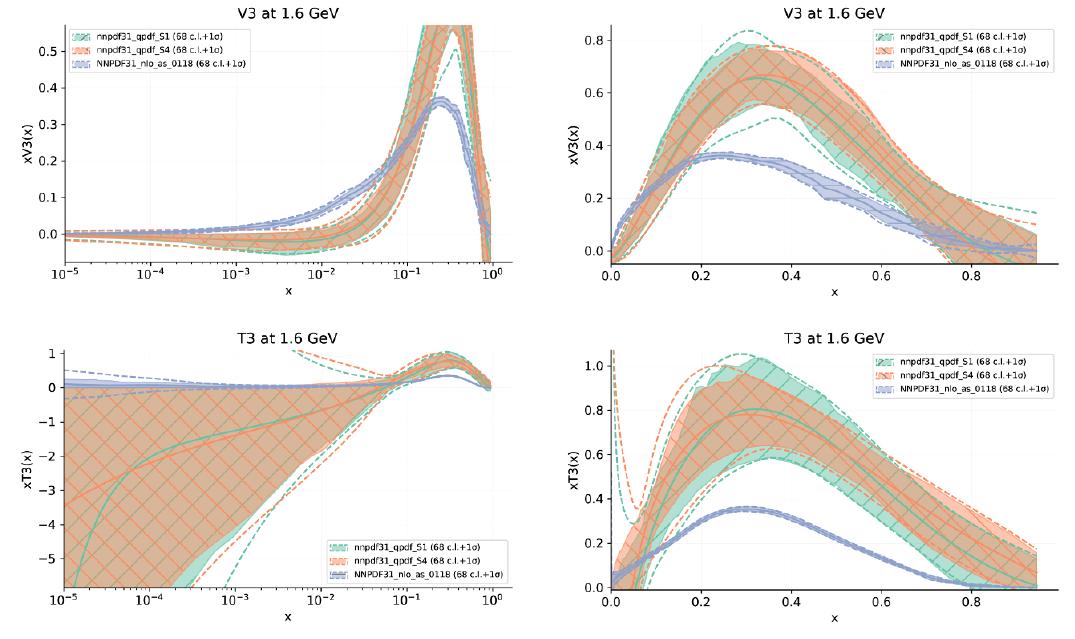
Figure 5 . S1 vs. S4: S1 results are sligthly more conservative than the S4 ones, but overall there is no signi(cid:12)cant di(cid:11)erence between the two optimistic scenarios.